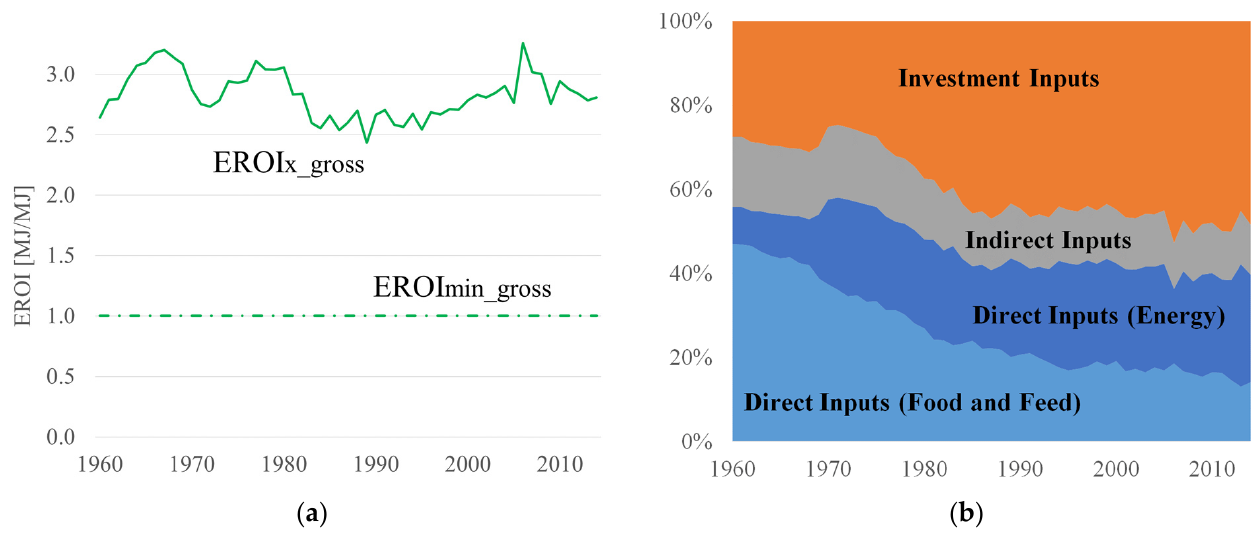
Figure 4. Extended-societal EROI results. ( a ) Gross EROI x ratio estimate for Portugal between 1960 and 2014 and the minimum gross EROI ratio. ( b ) Share of the energy inputs of the EROI. Authors’ own calculations. Full time series of EROI x is given in the Supplementary Materials file together with the series of inputs and outputs necessary for EROI calculation.